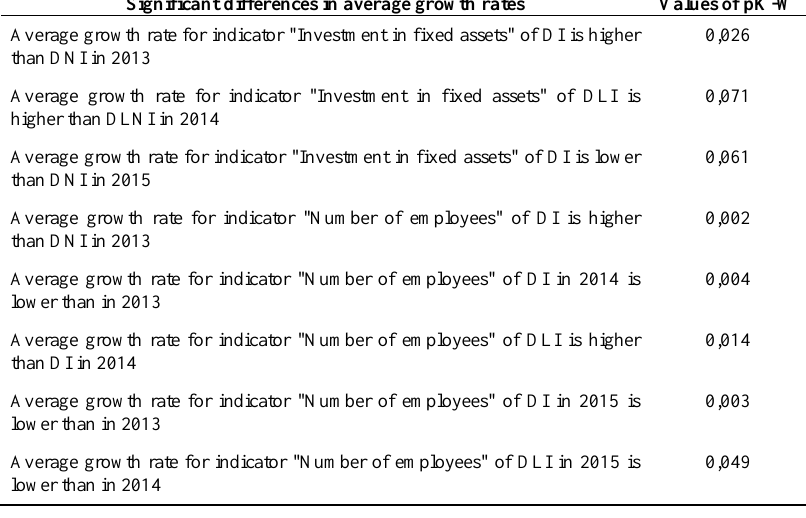
Table 2. Statistically significant differences in the growth rates of